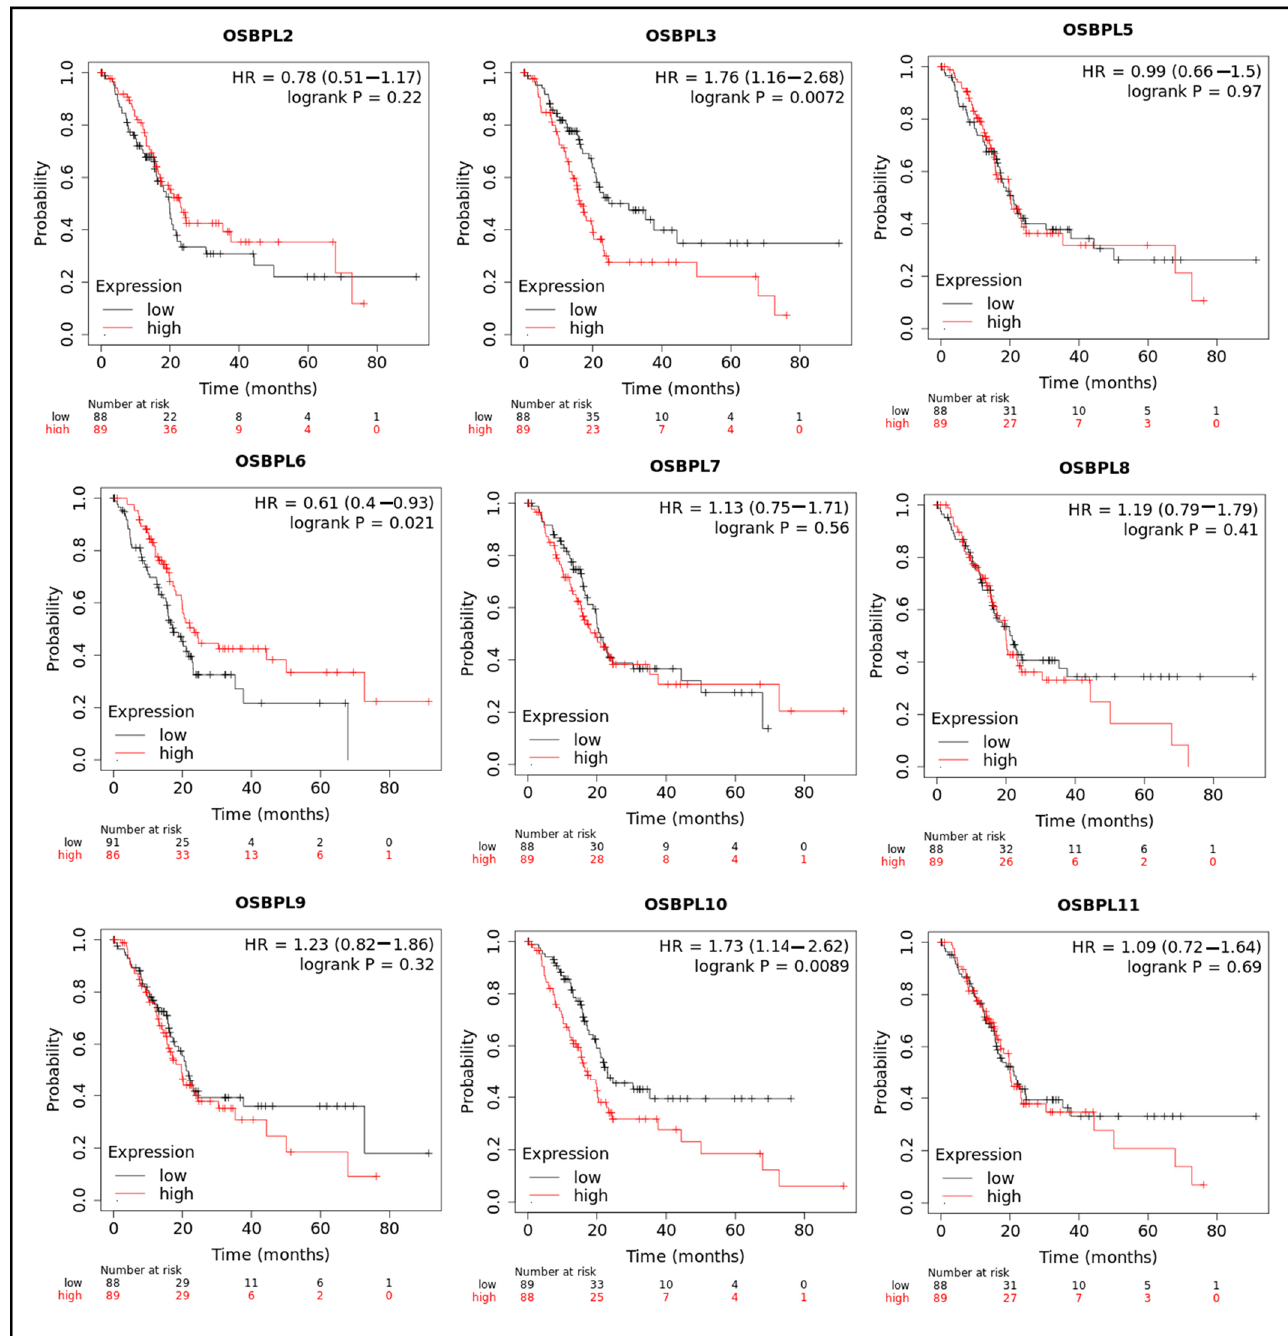
Figure 4. Prognostic values of transcription levels of oxysterol-binding protein (OSBP)-like (OSBPL) family members in pancreatic ductal adenocarcinoma (PDAC) patients in terms of overall survival (OS). Patients were divided based on median values via the Kaplan–Meier plotter platform.